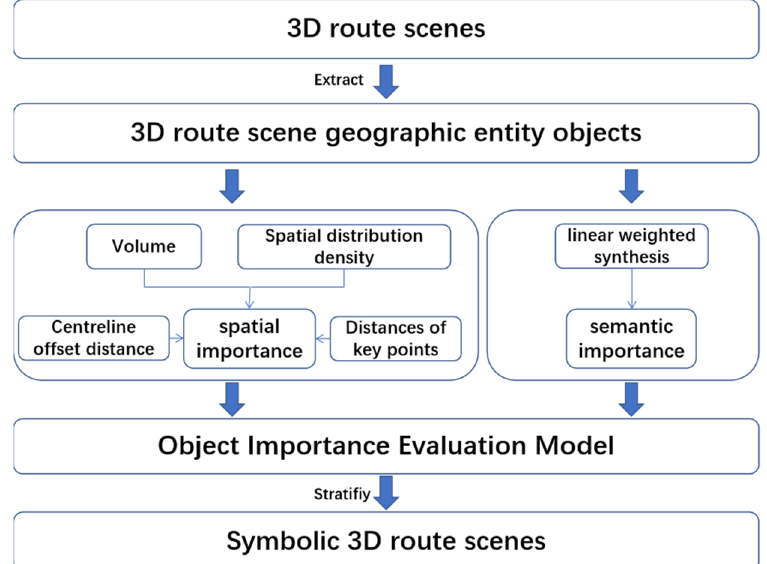
Figure 1. A technological roadmap for the construction of symbolic 3D route scenes according to the importance of objects.